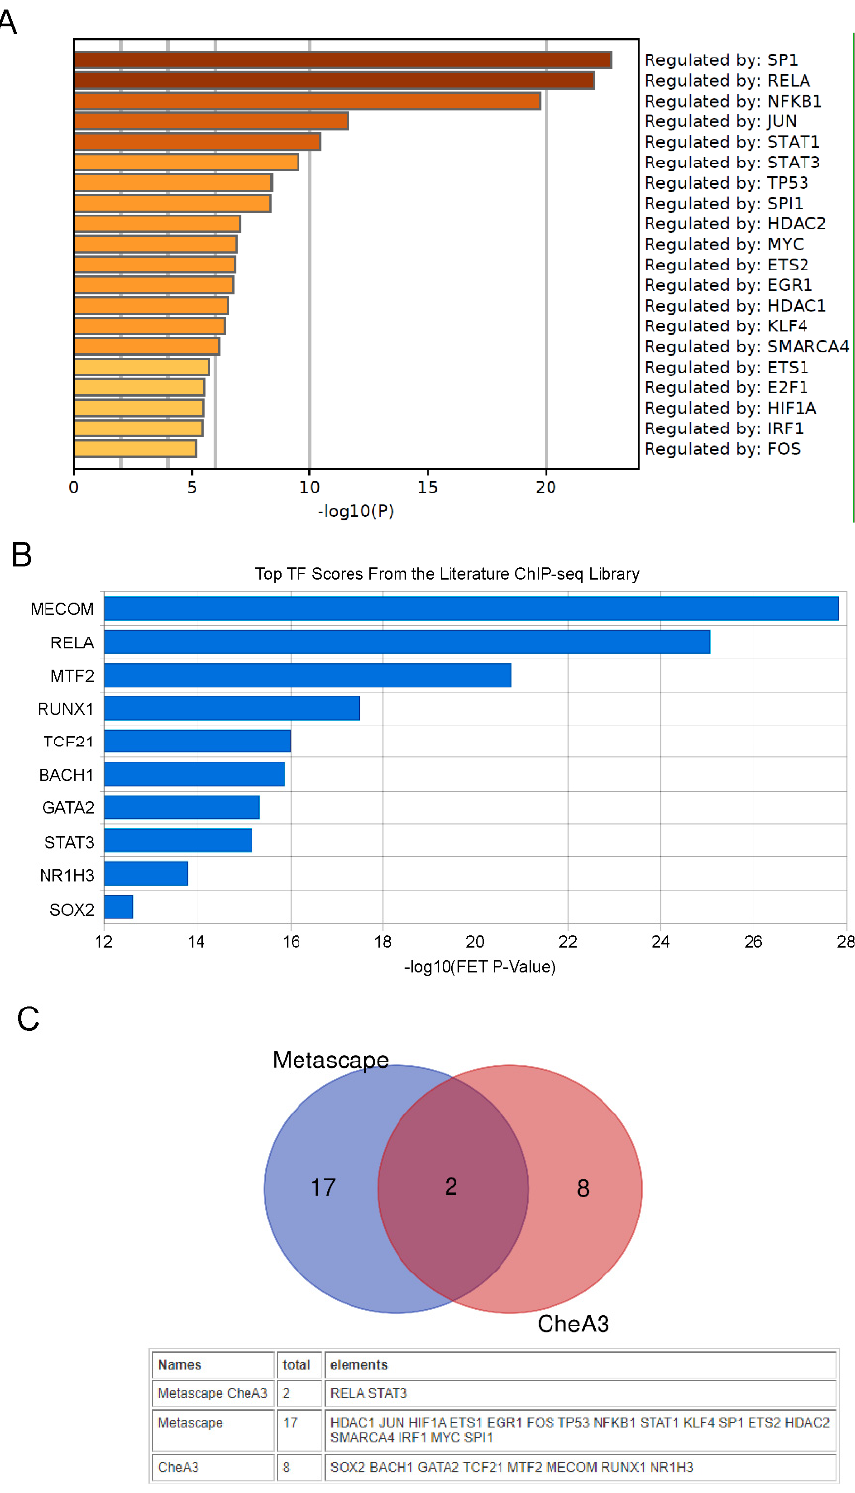
Figure 3. Prediction of transcription factors (TFs) responsible for observed changes in gene expression by Metascape and CheA3 TF enrichment analysis tools. DT treated NSCs up-regulated genes governed by TFs predict by Metascape ( A ). DT treated NSCs up-regulated genes governed by TFs predict by CheA3 ( B ). Venn diagram showing TF overlap (RELA and STAT3) between Metascape and CheA3 ( C ).